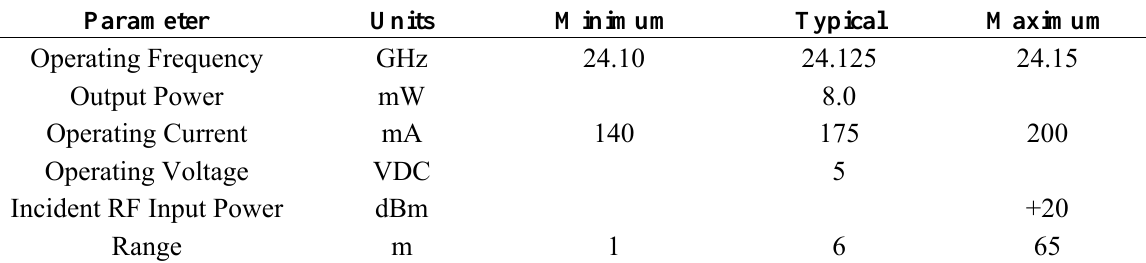
Table 1. Overview of the radar